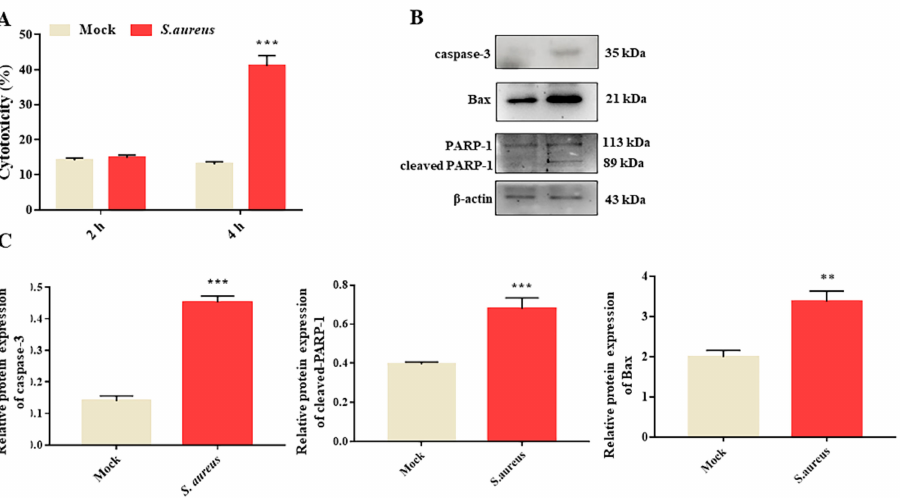
Figure 1. S. aureus induces gEECs apoptosis. ( A ) The cells’ cytotoxicity was measured by the LDH assay of S. aureus -infected (10 MOI) gEECs for 2 h and 4 h. ( B ) gEECs were infected with S. aureus for 4 h, and were subjected to immunoblot analysis for apoptosis-associated proteins. ( C ) The relative protein expression was calculated by comparing the ratio of the detected band with the β -actin levels. Each experiment was repeated three times. ** p < 0.01, *** p < 0.01 vs. the mock